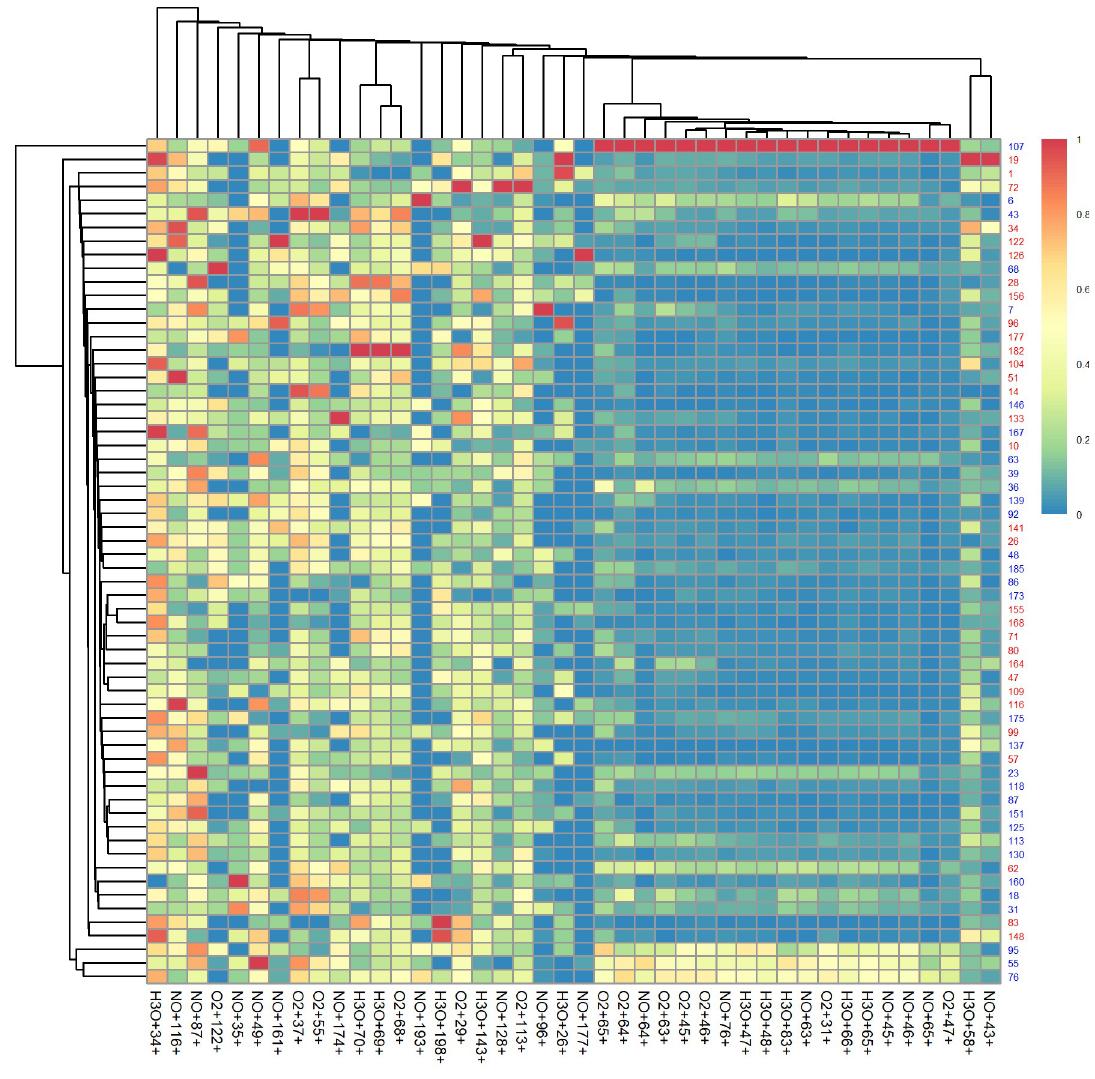
Fig 2. Relative abundance of breath VOCs in CDI. This heatmap with cluster dendrogram shows the distribution of concentration of various product ions in patients with (red labels) and without CDI (blue labels). Scaled relative concentrations of product ions are depicted in the heatmap by colors on a spectral scale. The linkage method used for hierarchical clustering was the nearest neighbor